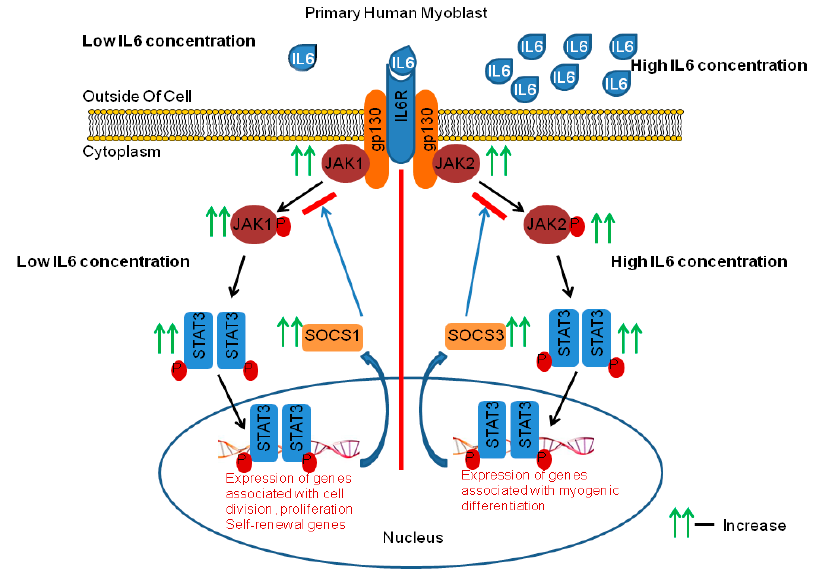
Figure 12. Schematic summary of IL-6 induced effects on the JAK-STAT pathway and its main regulator, SOCS. Low IL-6 concentration depicted on the left side and high IL-6 concentration on the right. Green arrows indicate findings of this study.